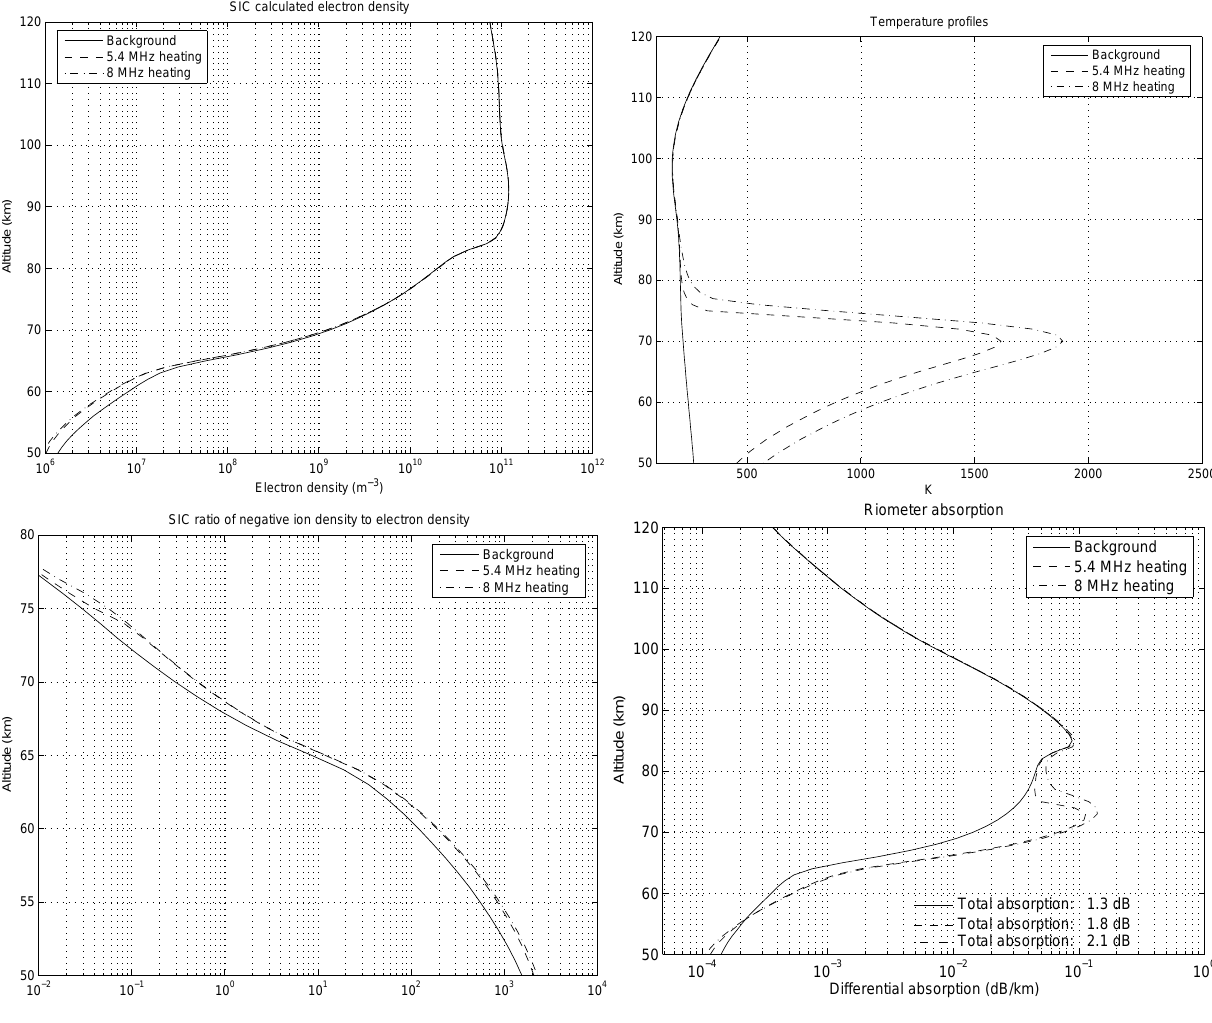
Fig. 4. The electron precipitation noon case, altitude profiles at the end of the heating interval (12:55 UT) for the background run and the two heating cases of 0.6GW ERP at 5.4 MHz and 1.2GW ERP at 8MHz. Plot 1: SIC modelled electron density; Plot 2: Electron temperatures; Plot 3: The ratio of negative ion density to electron density (NOTE: this is only shown for altitudes up to 80km); Plot 4: The calculated cosmic noise absorption at 38.2MHz as observed by a narrow riometer beam tilted by 45 ◦